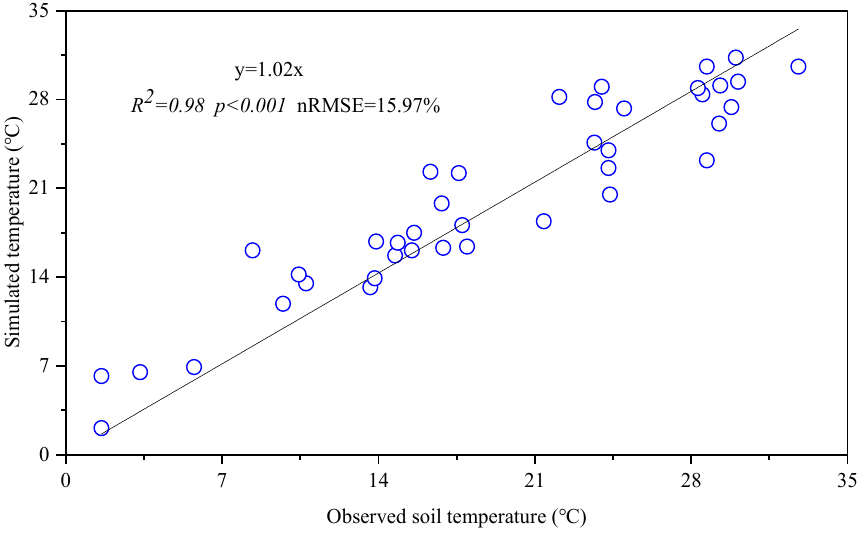
Figure 2. Comparison of simulated and observed soil temperature (0 − 5 cm) during 2015 − 2017. Based on a comparison of the simulated annual cumulative N 2 O emissions under FP and PT treatments (2.70 and 1.92 kg N ha − 1 , respectively), the observed values showed a small discrepancy due to overestimation (Figure 3). However, the nRMSE with a value of 26.51% demonstrated that the simulation deviations were within an acceptable range (nRMSE < 30%)